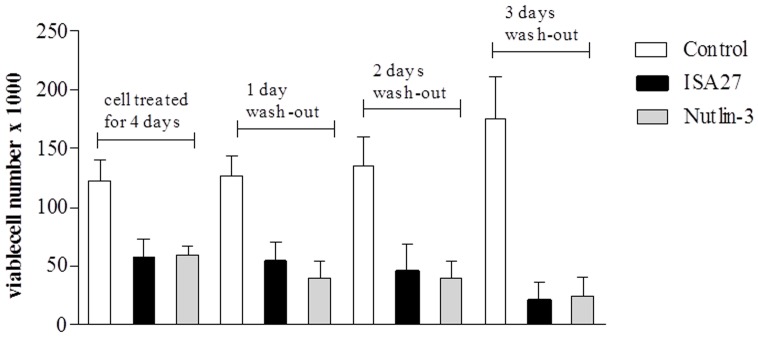
U87MG cells did not recover normal growth upon removal of ISA27.U87MG cells were cultured in the presence of 2.5 µM ISA27 or 10 µM Nutlin-3. After 4 days of MDM2 inhibitor treatment, cell culture medium was replaced with fresh culture medium without the MDM2 inhibitor. The figure shows the number of viable cells that were counted by Trypan blue exclusion after 4 days of MDM2 inhibitor treatment and 1, 2 and 3 days after MDM2 inhibitor removal. Data represent the means of three independent experiments performed in duplicate; bars, SEM.